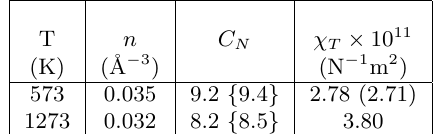
Table 2. Results obtained for the coordination number C N and isothermal compressibility χ T at the two thermo- dynamic states considered. Values in the parenthesis are experimental data [16], and in the curly bracket ab-initio results obtained with 205 particles